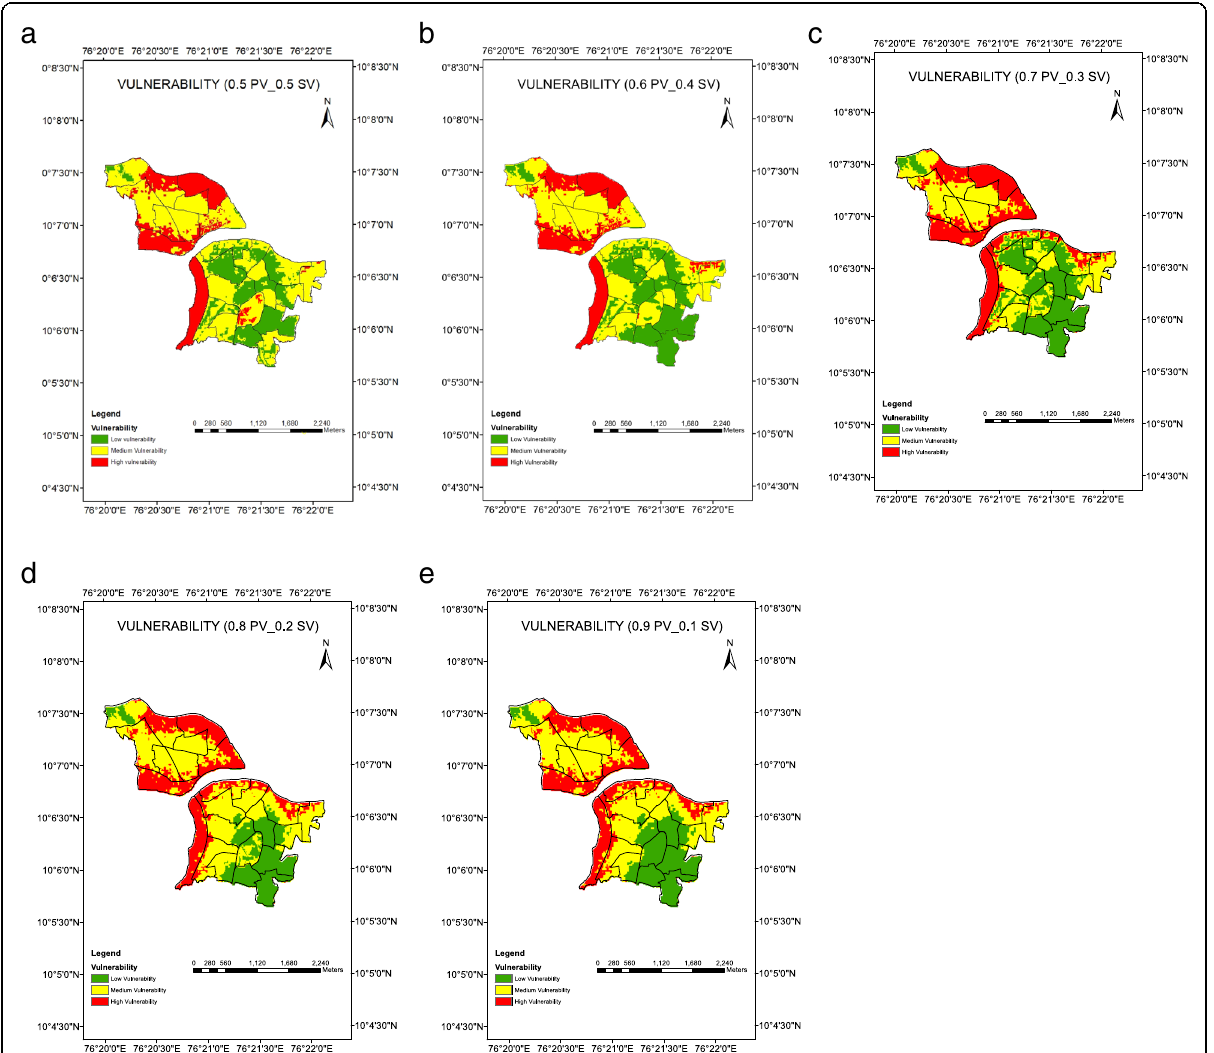
Fig. 13 Vulnerability map using different combinations of PV and SV a 0.5 PV-0.5 SV, b 0.6 PV-0.4 SV c 0.7 PV-0.3 SV d 0.8 PV-0.2SV e 0.9 PV- 0.1